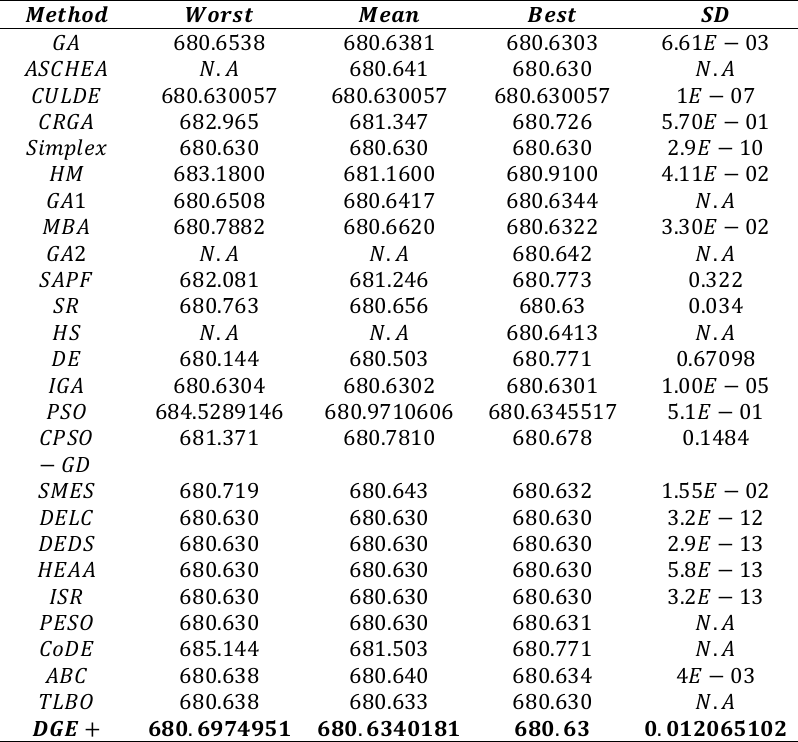
Table 12. Statistical comparison of results for constrained problem 6 of various